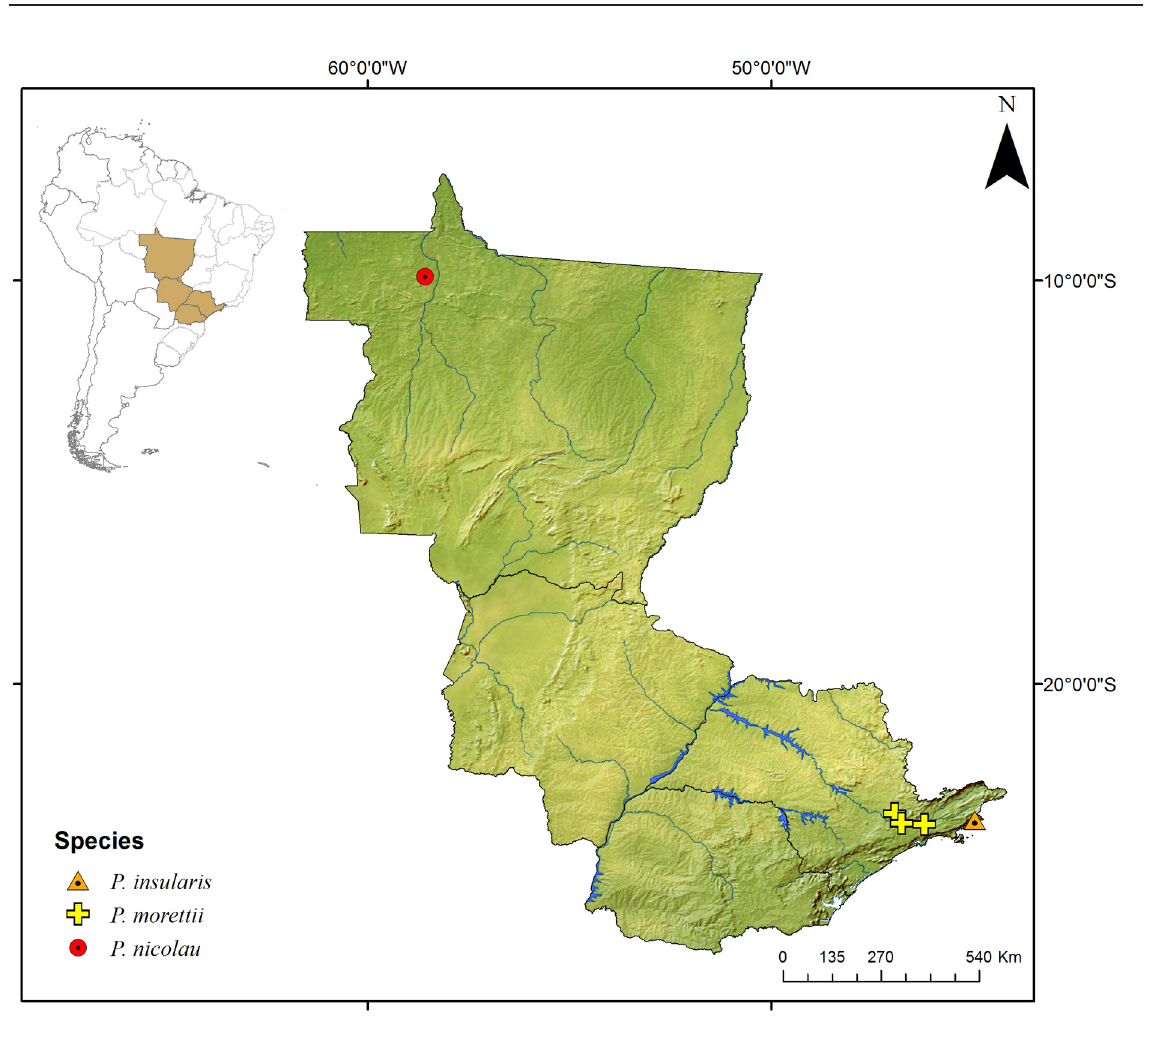
Fig. 191. Distribution map of the species Pseudonannolene insularis sp. nov., P. morettii sp. nov., and P. nicolau sp.